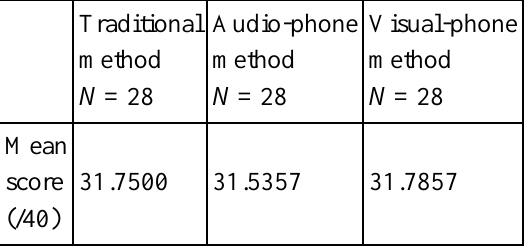
Test Scores by Testing Method (Adapted from Whattananarong, 2004) Traditional Audio-phone Visual-phone method method N = 28